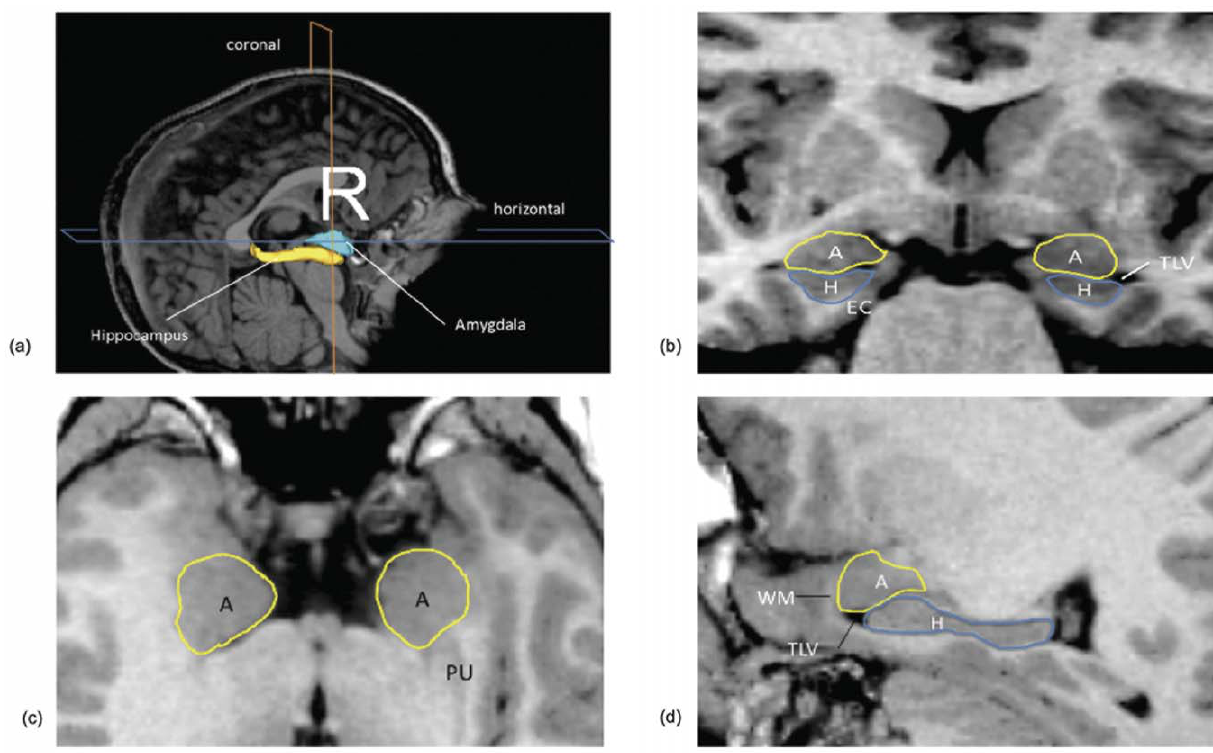
Figure 1. Orthogonal views for segmenting the amygdala and hippocampus on MRI sections. A three-dimensional reconstruction of images (a) in which lines indicate the position of the horizontal plane (b), sagittal plane (c), and coronal plane (d) is shown. A, Amygdala; EC, entorhinal cortex; H, hippocampus; PU, putamen; TLV, temporal horn of the lateral ventricle; WM, subamygdaloid white matter. doi:10.1371/journal.pone.0046970.g001 age. ANOVAs (sex 6 age group) for whole brain volume, amygdala volume and hippocampal volume showed main effects of sex (whole brain: males . females, F(1, 103) =4.72, p= 0.03; amygdala: males . females, F(1, 103)= 4.78, p= 0.03; hippo-